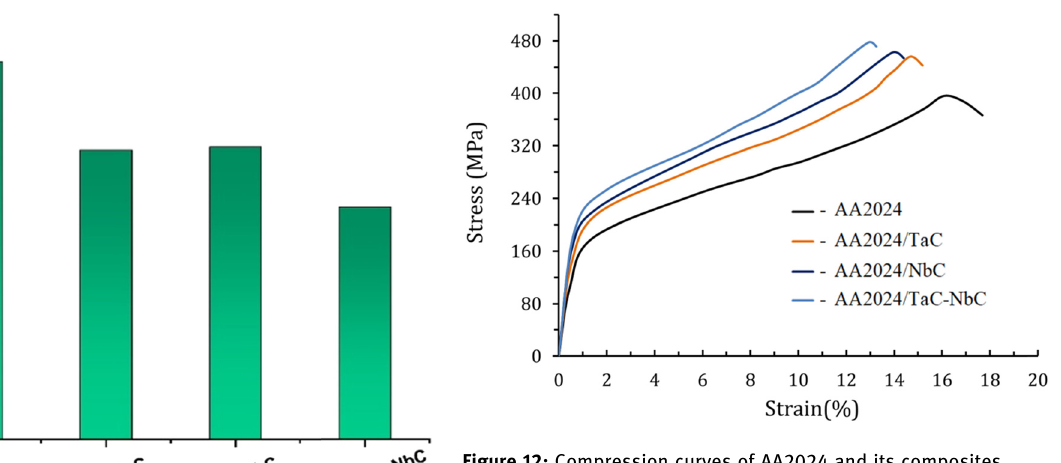
Figure 12: Compression curves of AA2024 and its